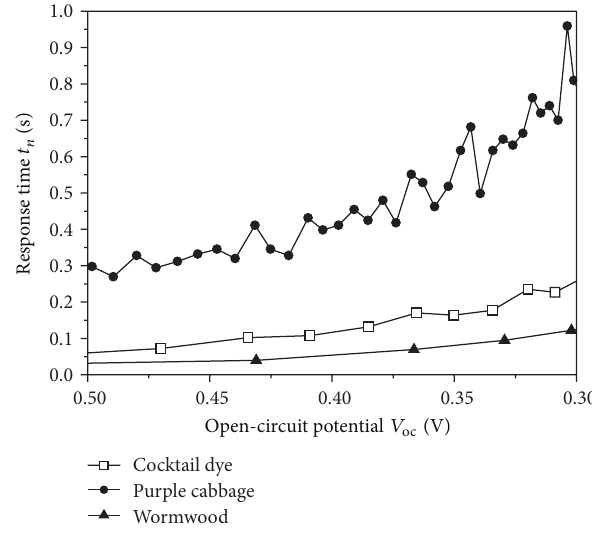
Figure 7: J-V curves of DSSCs sensitized by cocktail dyes with different thicknesses of TiO 2 .